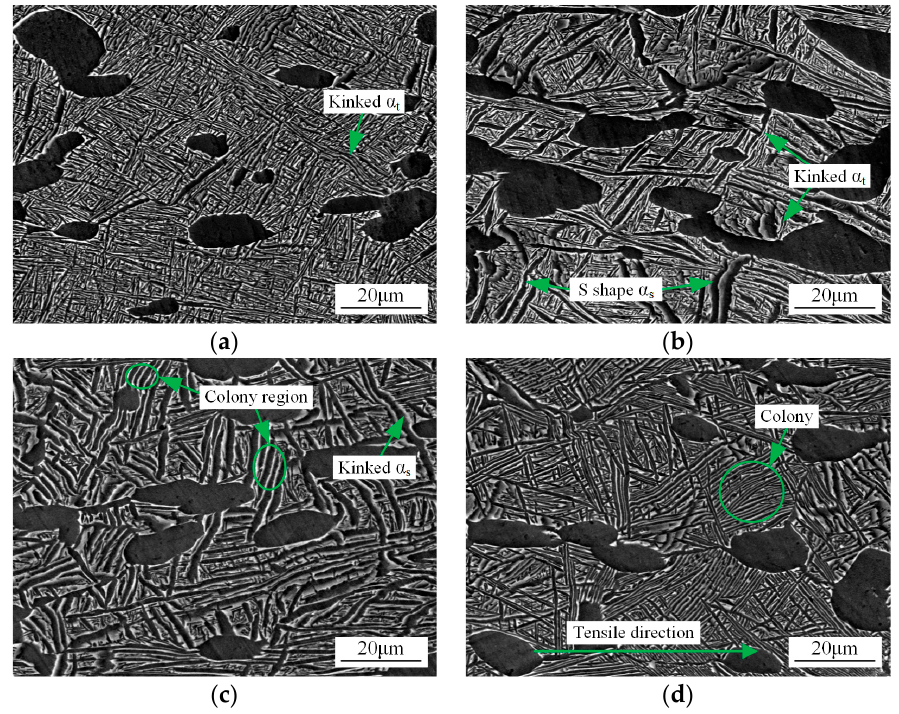
Figure 6. Microstructures near the fracture surface of TA15 alloy tensile samples under different processing routes: ( a ) S1, ( b ) S2, ( c ) S3, ( d ) S4.